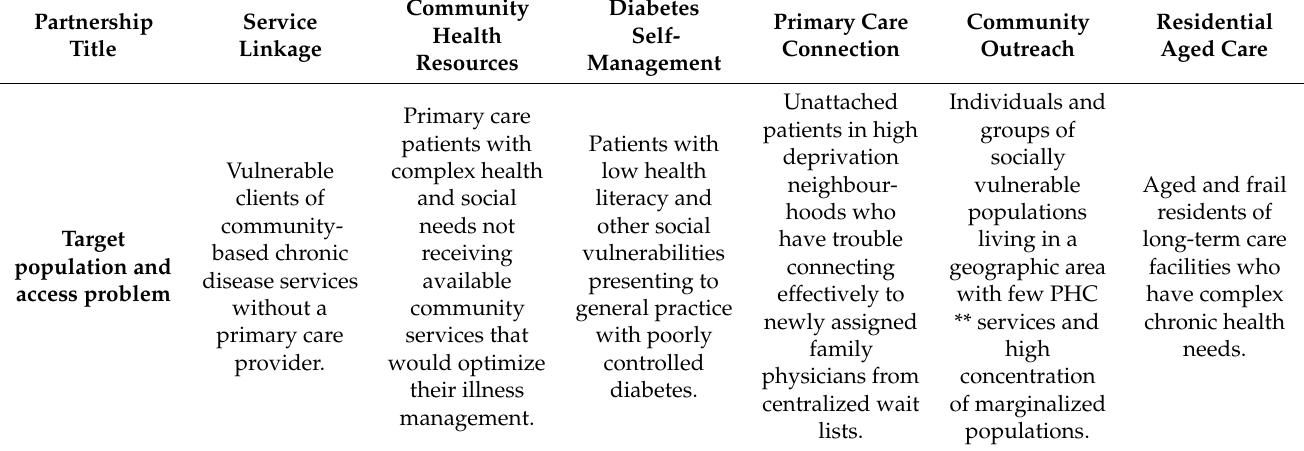
Table 1. Overview of characteristics of interventions in six IMPACT * local partnerships (adapted from [34,35]). Partnership